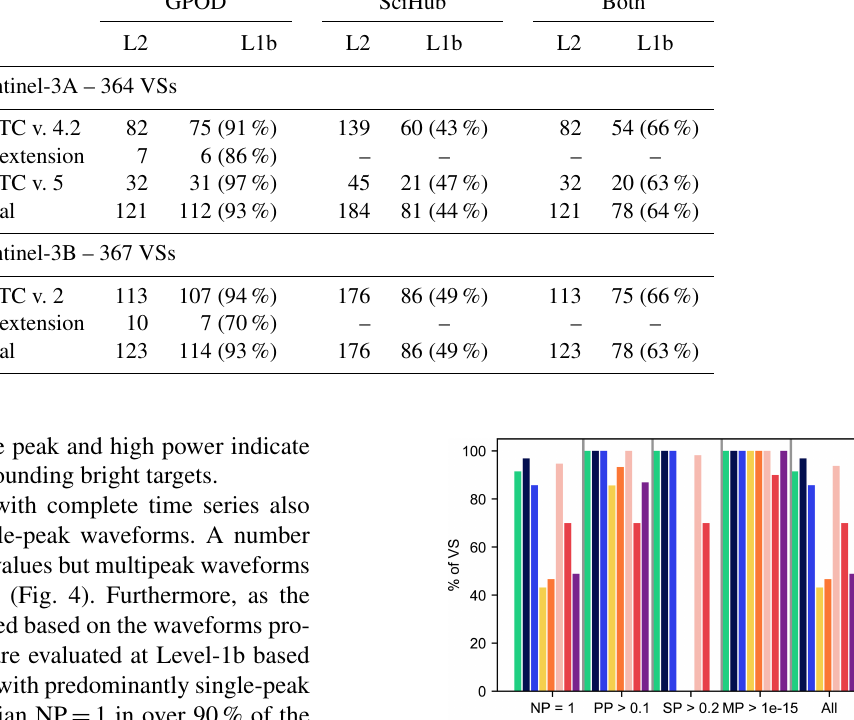
Table 3. Number of VSs fulfilling criteria of Level-1b (L1b, % of VSs retained from Level-2) and Level-2 (L2) in GPOD and SciHub datasets using the Samosa + and OCOG retrackers, respectively, and in both datasets. We consider S3A VSs with data only after the OLTC update in March 2019 (line “OLTC v. 5”) as well as the two processing settings on GPOD (line “3 x window extension”) separately. The total contains all stations present in both datasets. GPOD SciHub